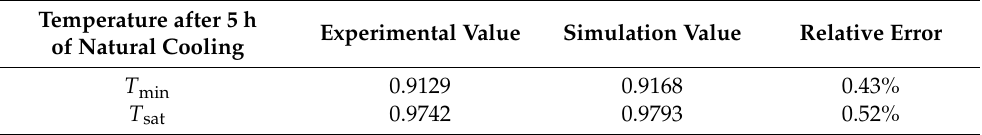
Figure 7. The variation of temperature at different heights of the steam generator in simulation. Table 1. Comparison of experiment and simulation results. Temperature after 5 h